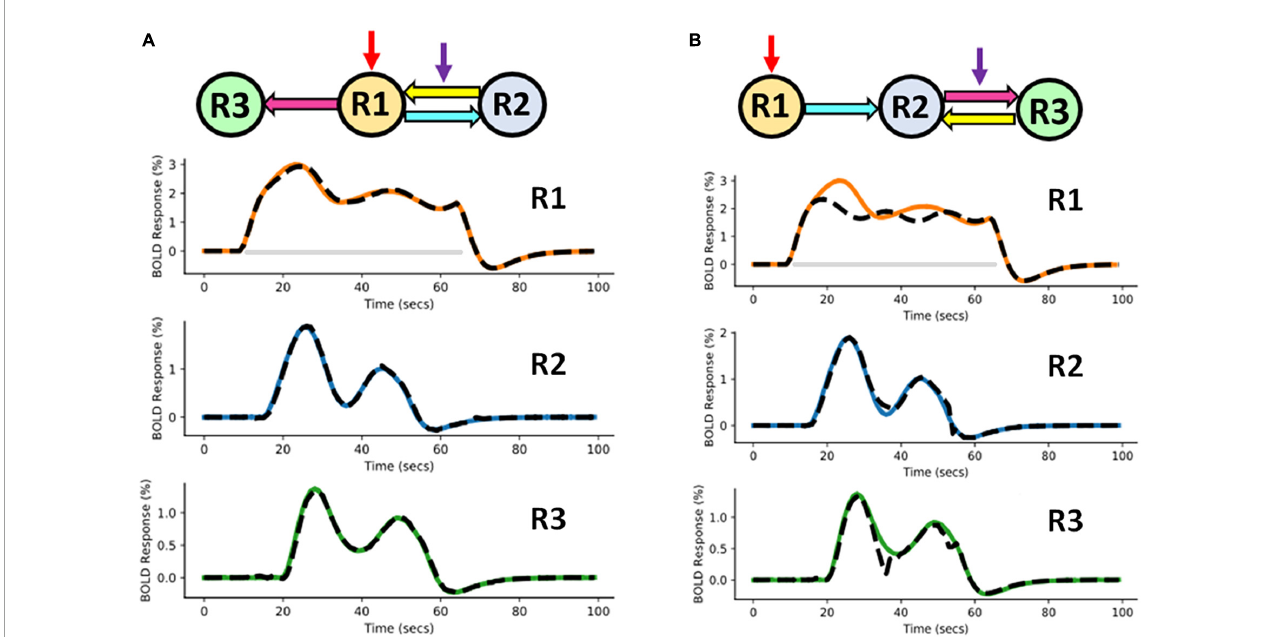
FIGURE5 Competing hypotheses models (A) m 1 (ground truth model) and (B) m 2 (randomly chosen model) along with the corresponding area-specific functional magnetic resonance imaging (fMRI) blood oxygenation level-dependent (BOLD) responses. The black dashed lines represent the predicted responses and the colored time courses are the ground truth values. The red and purple arrows represent direct and modulatory inputs, respectively.